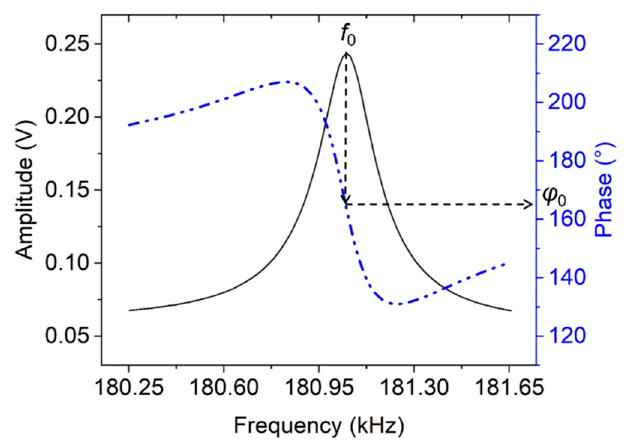
Figure 13. Symmetric amplitude shape with extended range of monotonic phase response. The phase set point ϕ 0 for the phase-locked loop (PLL) corresponds to the frequency f 0 of the amplitude maximum.